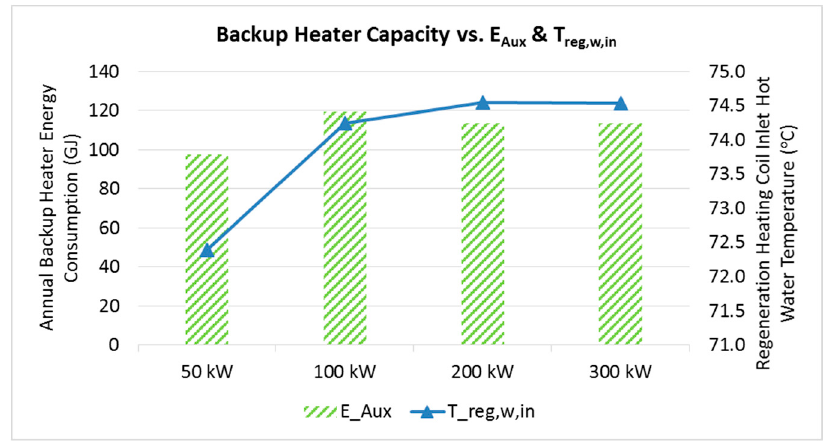
Figure 14. The impact of varying backup heater capacity on E Aux and T reg , w , in .